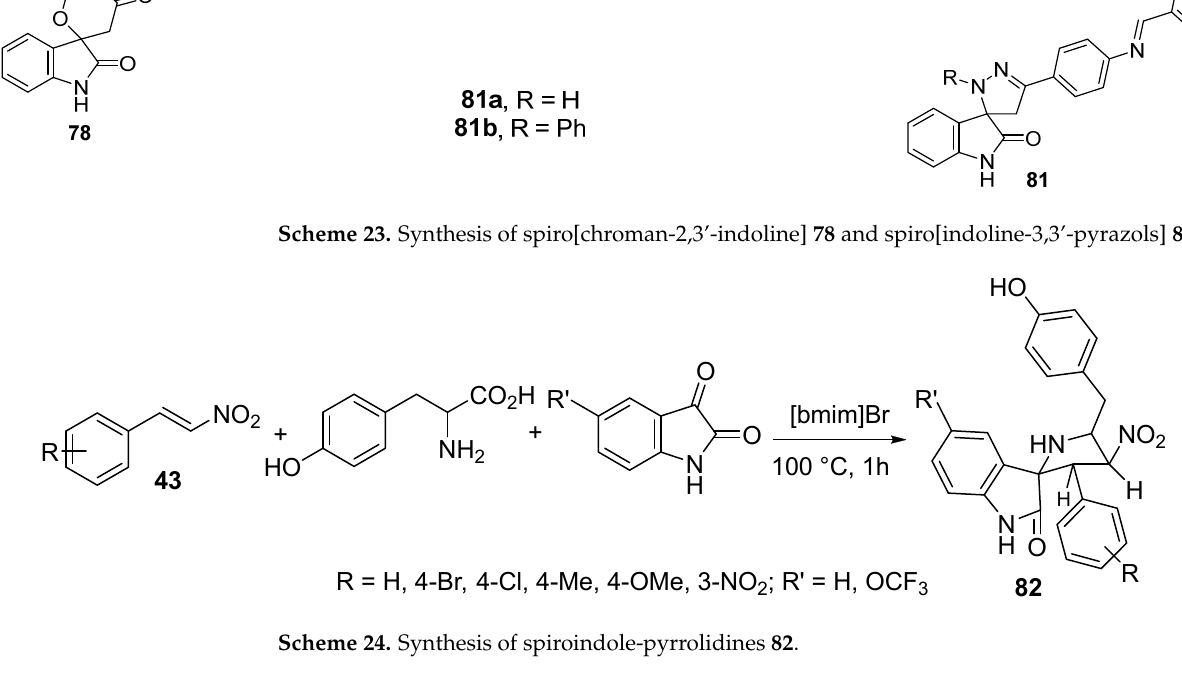
Ionic liquid [bmim]Br, mediated (100 °C) azomethine (formed from the condensation